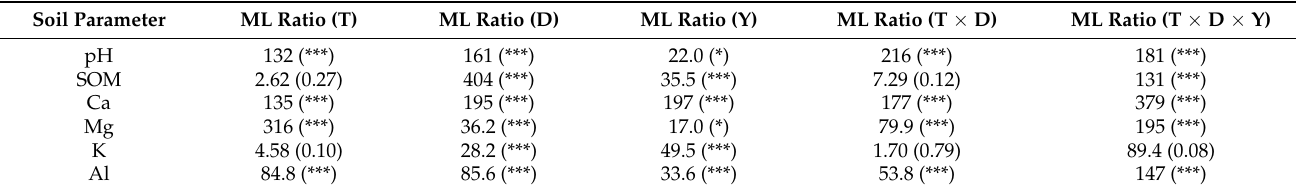
Table 1. Analysis of variance performed on soil parameters (pH, SOM, Ca, Mg, K and Al). The variability in the soil parameters was evaluated using the hierarchical multilevel model (maximum likelihood (ML) ratio). The results were significant at * p < 0.05 and *** p <